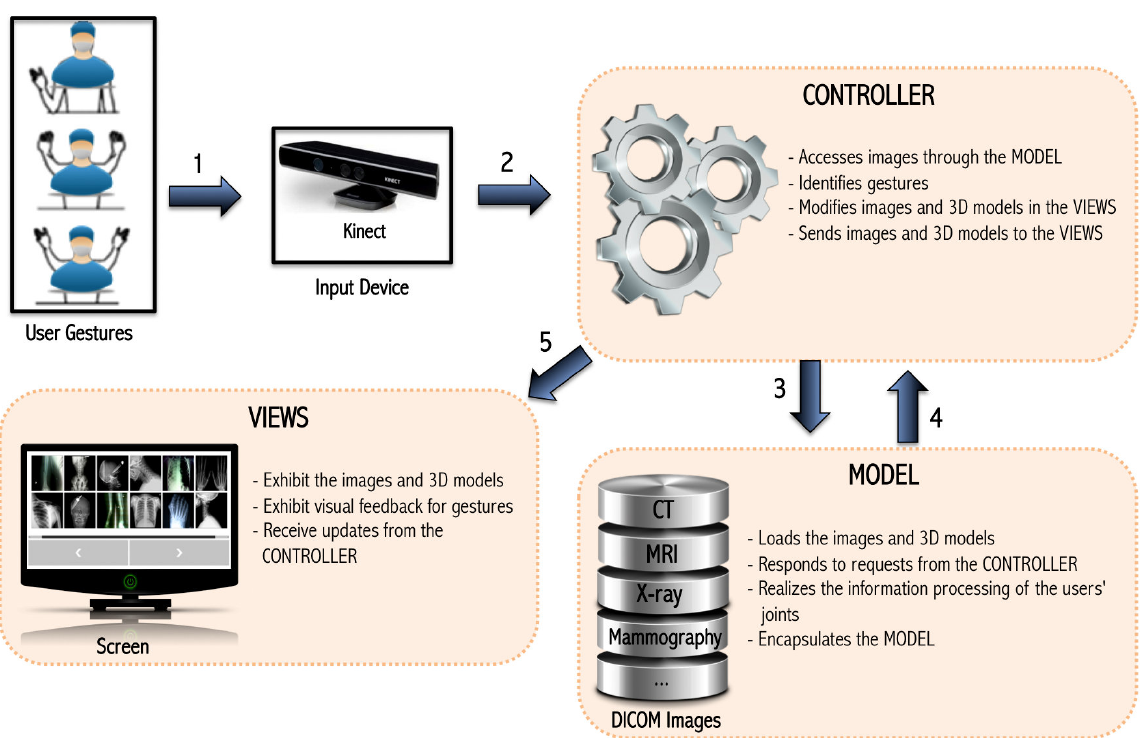
Fig. 4: Architecture of the gesture-controlled system. The user performs a gesture that is identified by the camera of the Kinect input device. Through the C ONTROLLER , the V IEWS of the M ODEL are modified according to the user selected functionalities. the library created and with the SDK, both used together with the Kinect device; (2) there is a vector rendering engine at its core, able to access the graphics hardware resources; and (3) it contains appropriate libraries for the development of 2D and 3D